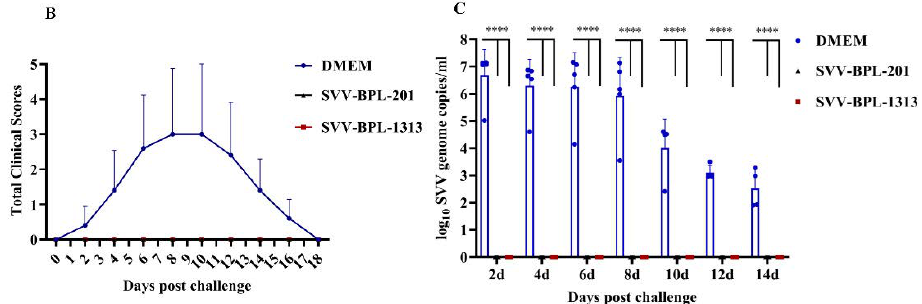
Figure 4. Vesicular lesion, clinical scores, and viremia of pigs, post infection challenge. ( A ) Vesicular lesion observed on pigs in the immune group and control group, challenged with SVV LNSYO1-2017. ( B ) Clinical scores of the pigs challenged with SVV LNSYO1-2017. Data represent the mean ± SD. ( C ) Detection of the viremia levels in the serum of pigs challenged with SVV LNSYO1-2017. Data represent the mean ± SD. Significance was determined using ANOVA (**** p < 0.000001).